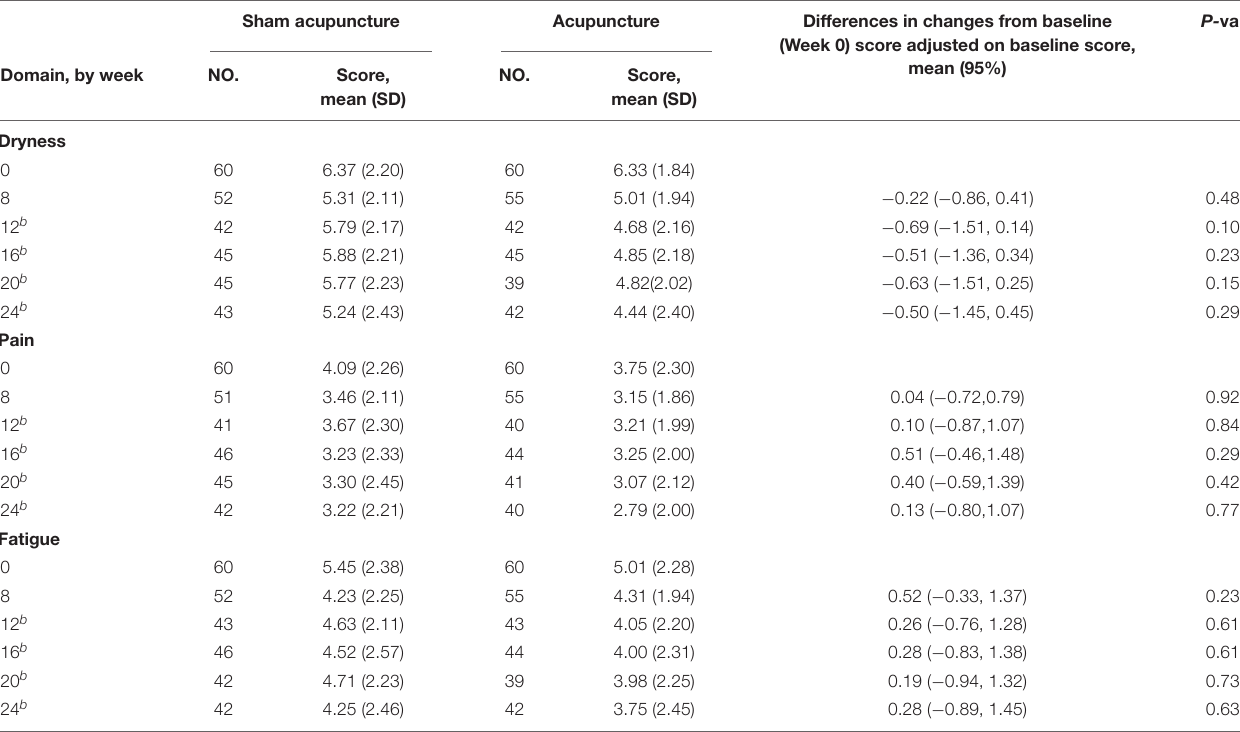
TABLE 4 | Numeric analog scale a scores for dry, pain, and fatigue between weeks 0 and 24, by group. Sham